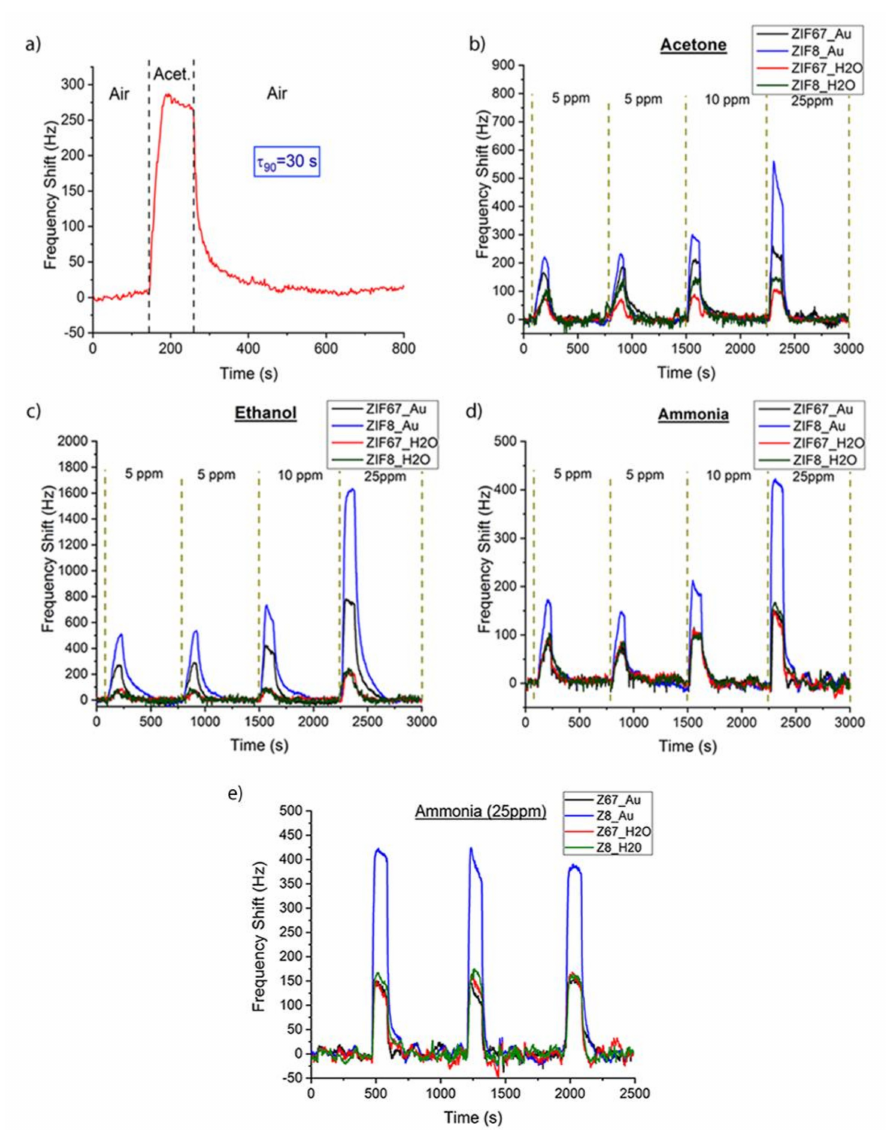
Figure 8. ( a ) SAW eNose response to 10 ppm of acetone. Experimental response for 5 ppm, 10 ppm and 25 ppm of ( b ) acetone, ( c ) ethanol and ( d ) ammonia with S1, S2, S3, and S4 sensitive layers. ( e ) Three consecutive measurements for 25 ppm of